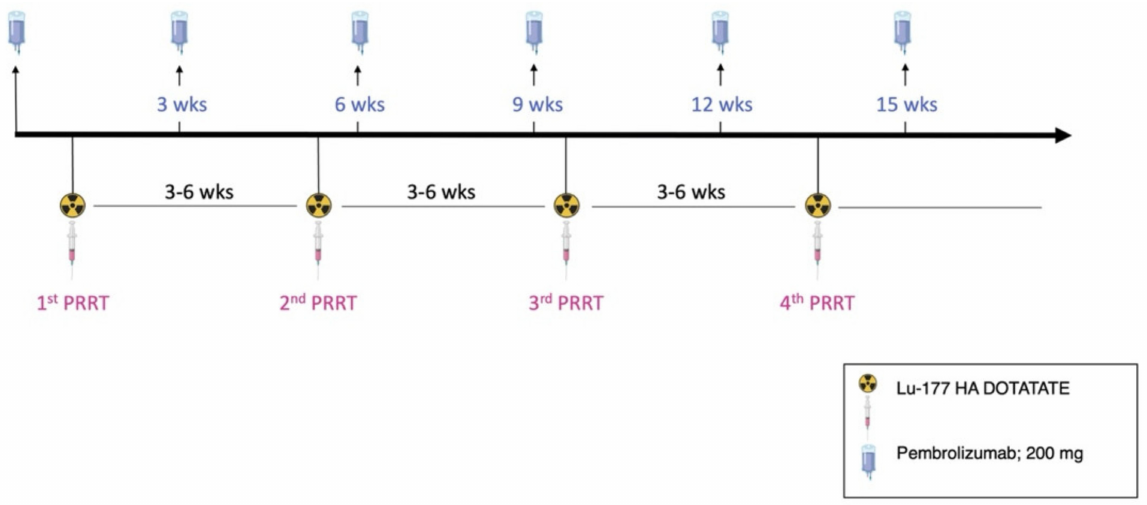
Figure 1. Protocol for the combinational treatment using pembrolizumab and